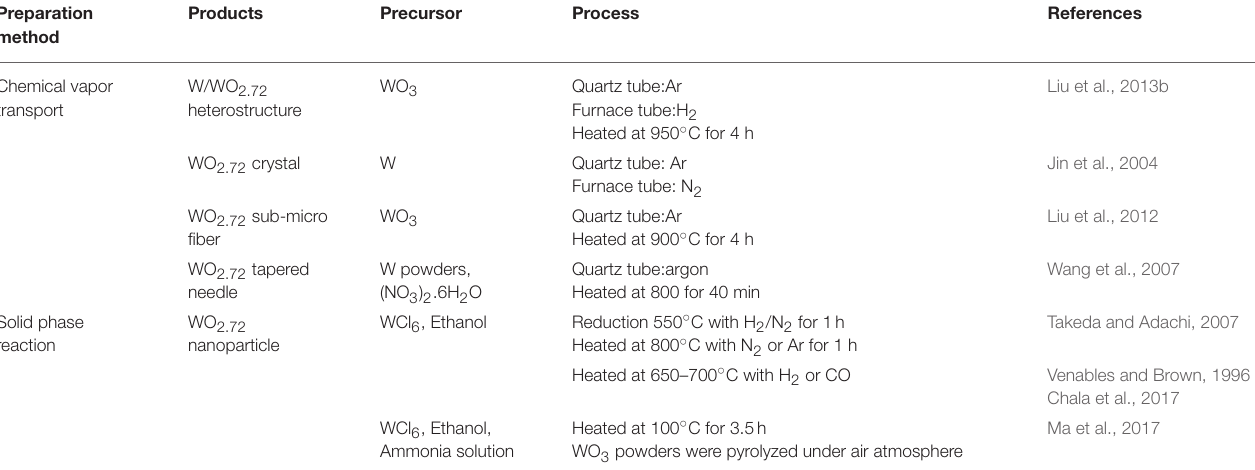
FIGURE 2 | Morphologies of WO 2.72 prepared with different reaction time. (A) nanoparticles, (B) nanorods, (C) nanowires. Reproduced with permission (Moshofsky and Mokari, 2012 ). Copyright 2012, Chemistry of Materials. (D) nanobundles. Reproduced with permission (Su and Lin, 2009). Copyright 2009, The Journal of Physical Chemistry C. (E) nanocrystals. Reproduced with permission (Guo et al., 2012c) Copyright 2012, American chemical society (ACS), and (F) urchin-like spheres. TABLE 2 | Preparations of non-stoichiometric tungsten-oxide (WO 2.72 ) by chemical vapor transport and solid phase